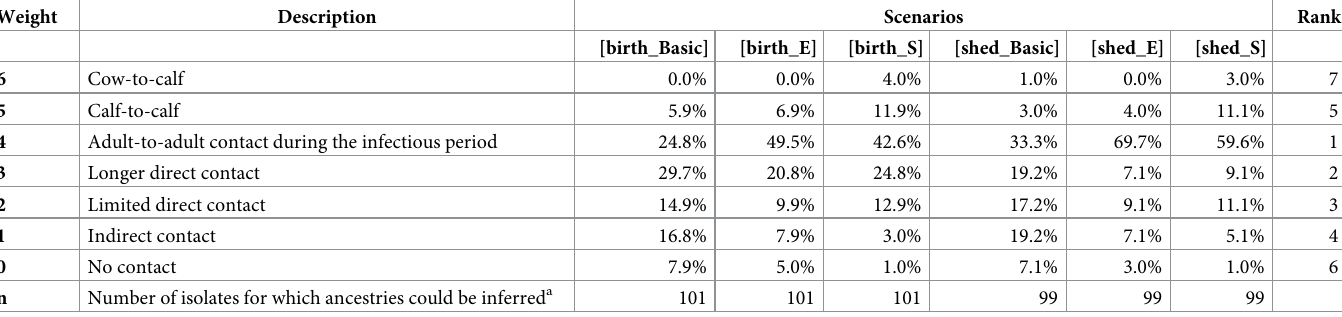
Table 1. Ranking of transmission routes. Ranking of transmission routes by the proportion of inferred ancestries based on social network patterns. Column per- centages add up to 100%. The overall rank was inferred from the sum of ranks of all scenarios.